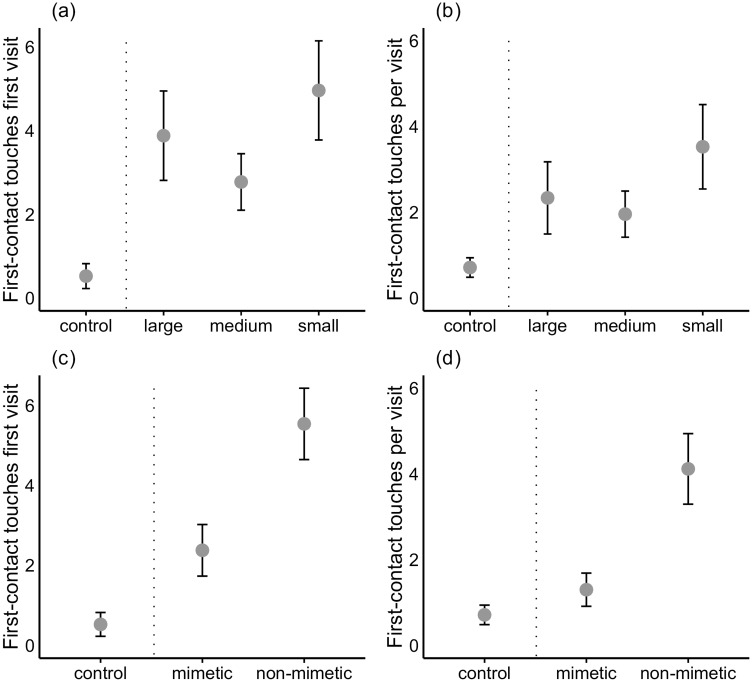
Recognition of the parasitic egg.First-contact touches during the first visit with respect to (a) size mimicry and (c) colour mimicry of the parasitic egg; and first-contact touches per visit with respect to (b) size mimicry and (d) colour mimicry of the parasitic egg. The figure also includes information from control nests (the dashed line separates control nests and those containing experimental eggs).